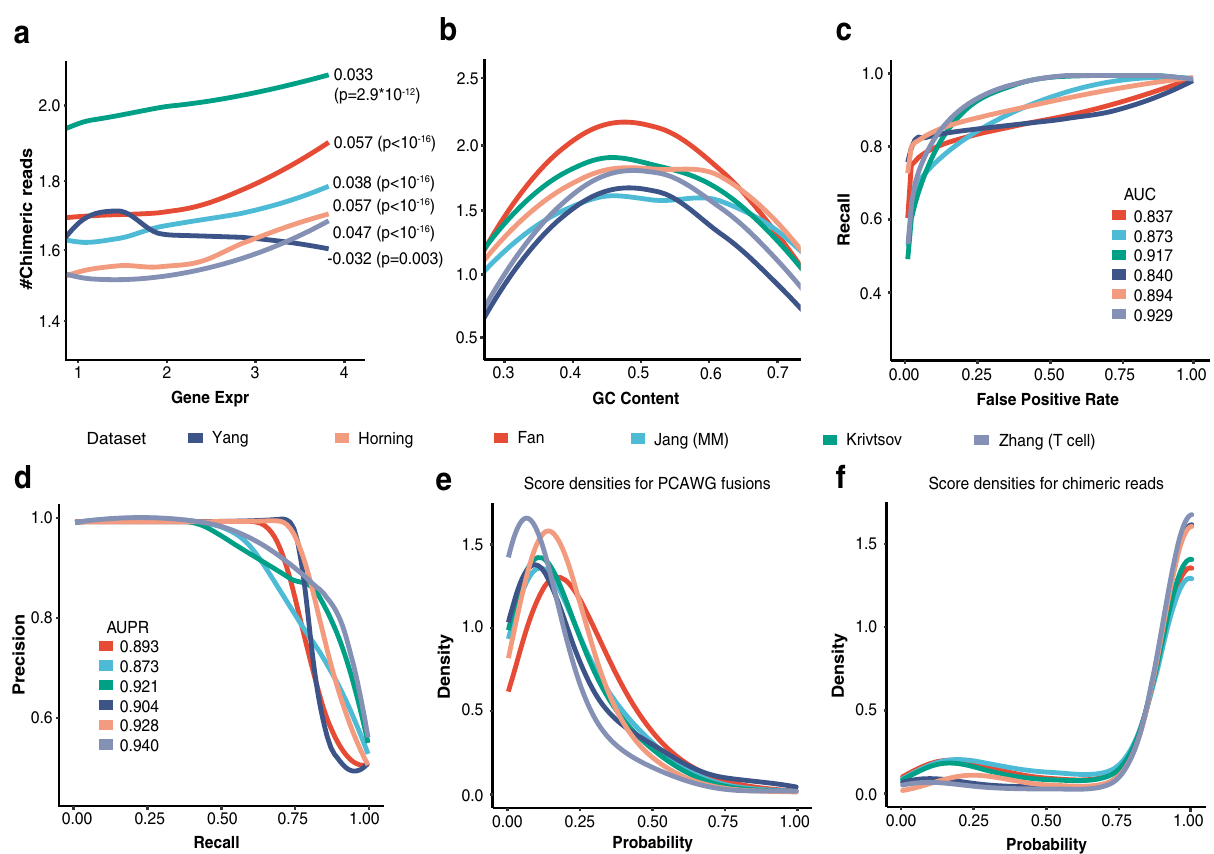
Fig. 2 Features of technical chimeric reads. The number of supporting chimeric reads depends on ( a ) the expression of partner genes and ( b ) the local GC content. The Pearson ’ s Correlations between the number of chimeric reads and the gene expression and the p-values are shown in the fi gure. P-values were calculated by two-sided Student ’ s t test. The GC content was calculated using sequences near breakpoints (200 bp). c The ROCs of the bi-LSTM model for different single-cell datasets (validation data). The AUCs are also shown. d The PR curves and their AUPRs. e The densities of the technical artifact score of gene fusions in the PCAWG study by the bi-LSTM models retrained using six different datasets. f The densities of the predicted probabilities of chimeric reads. The models are retrained using different datasets. Source data are provided as a Source Data fi